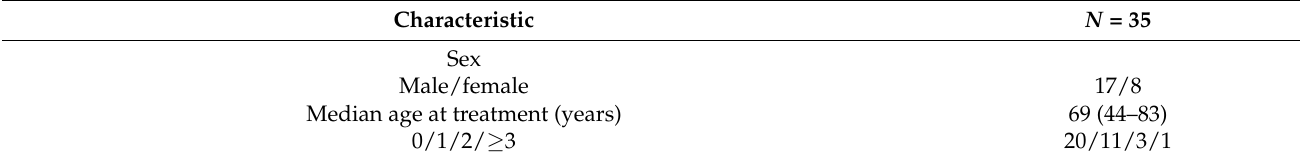
Table 1. Baseline characteristics of the